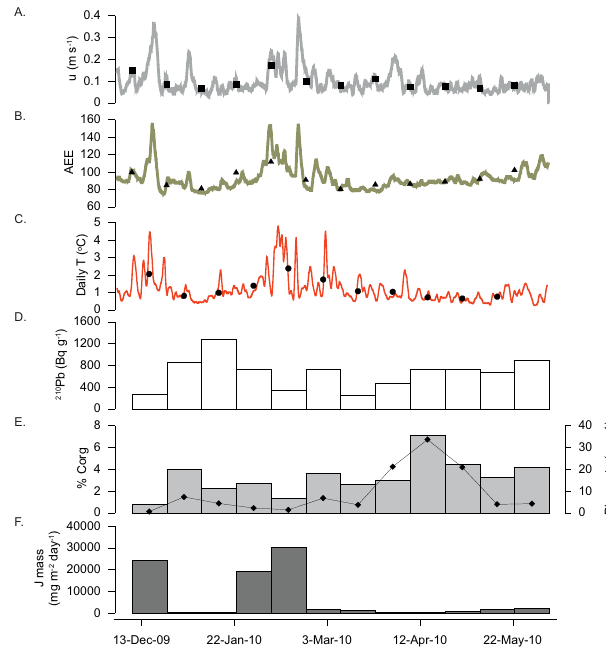
Fig. 11. Record of daily (line) and 16-day average (dots) of fluctu- ations of (A) current speed, (B) acoustic backscatter, (C) tempera- ture (daily 1T ), (D) organic carbon (%) and pigment concentration (µgg − 1 ) , (E) 210 Pb (Bqg − 1 ) , (F) total mass flux (mgm − 2 day − 1 )